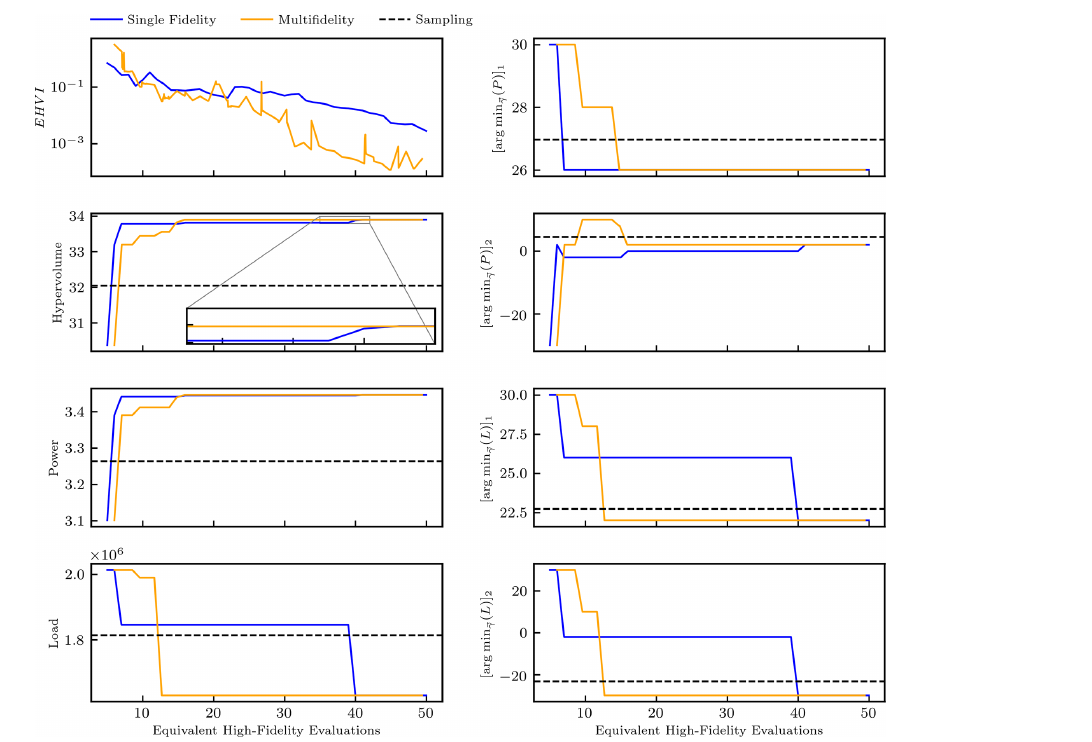
Figure 3. Convergence history of the single-fidelity and multifidelity approaches. The left plots show the EHVI, hypervolume, and best- observed power and loading. The right plots show the yaw configurations associated with the best-observed power and loading.